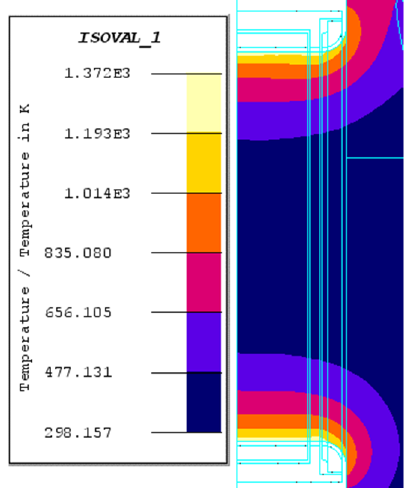
Figure 5. Temperature field of crankshaft N0 during the heating stage (T = 9S).